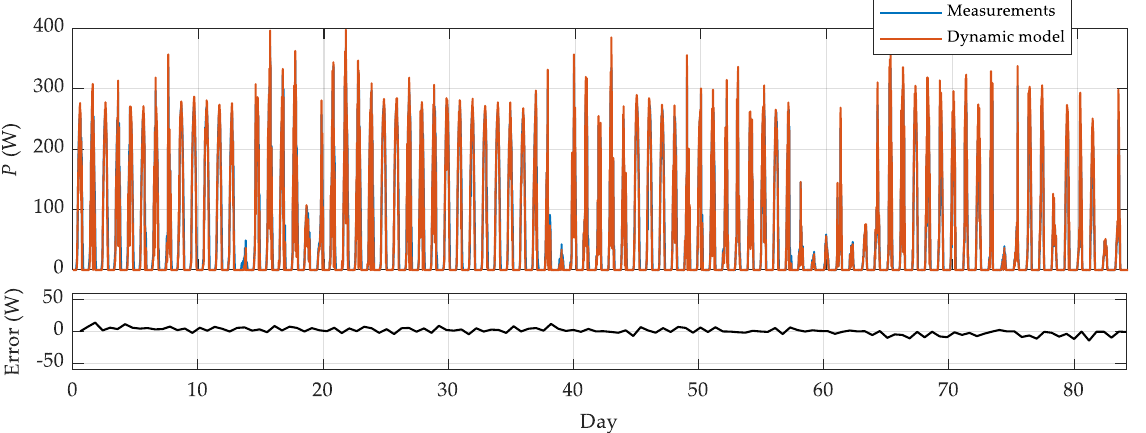
Figure 10. Validation of a dynamic electric model of a PV/T collector with measurements for 83 days.